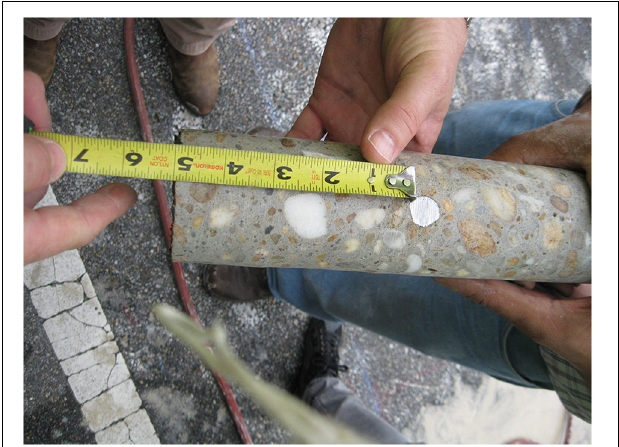
FIGURE 4 | Cylindrical concrete sample drilled (1 inch = 25.4